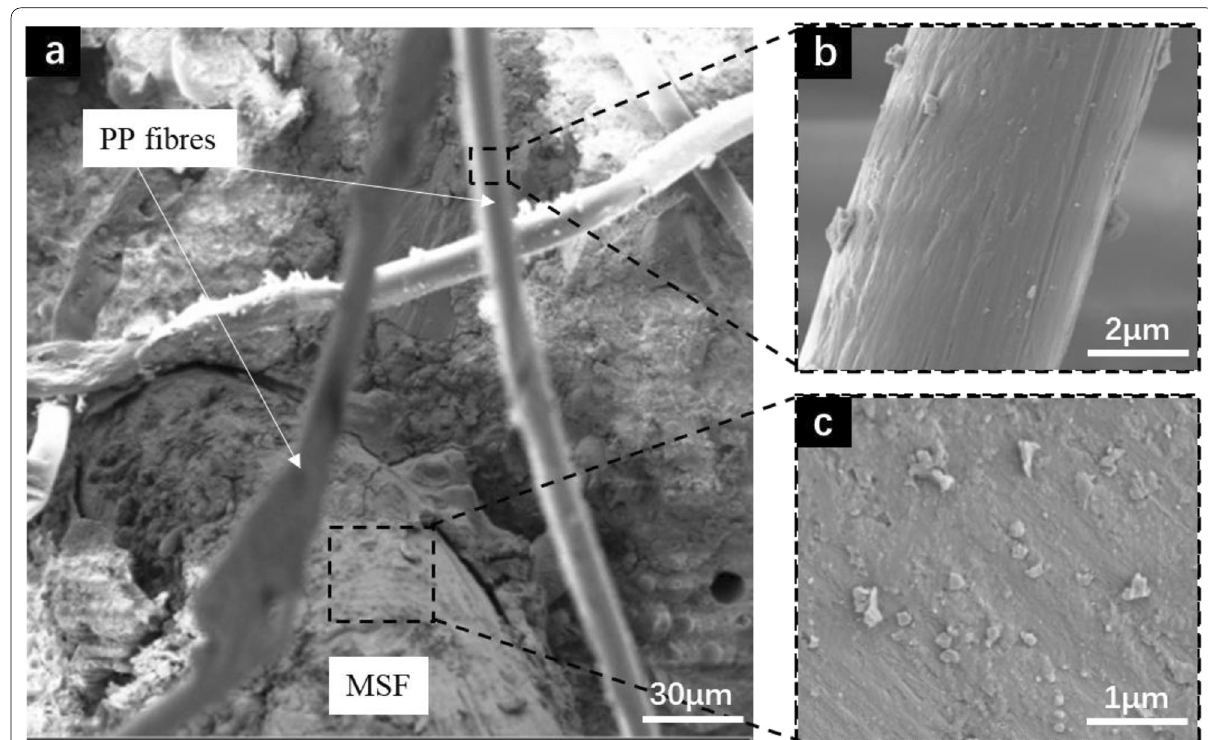
Fig. 10 a Mixed distribution of PP fibres and MSF, surface morphology. b PP fibres pull- c MSF after pulled out from MPC